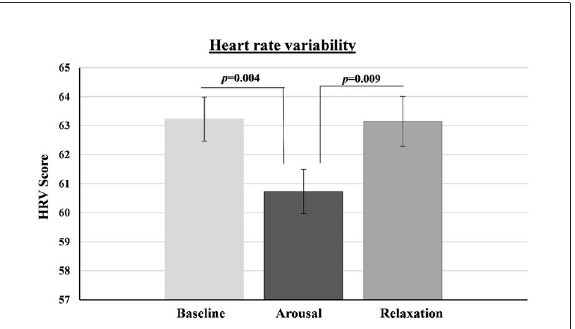
FIGURE3 Heart rate variability (HRV) at baseline, arousal phase and relaxation phase. Error bars represent